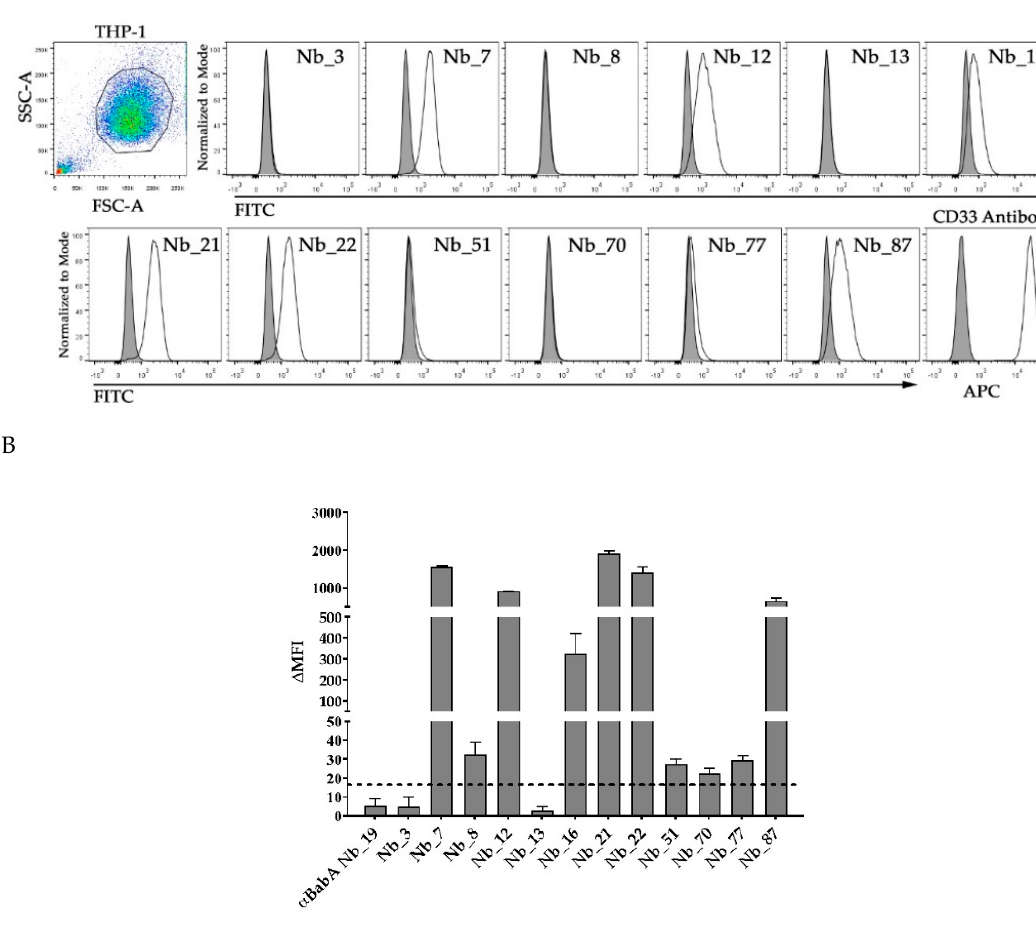
Figure 2. Purity of the anti-CD33 Nb preparations. ( A ) SEC profile of the Nb_12, showing a single peak of protein. (All other Nbs gave comparable chromatograms). ( B , C ) SDS-PAGE under reducing conditions, where proteins are revealed after staining with Coomassie blue ( B ) or by western blot, using a mouse anti-HA tag monoclonal antibody and a goat anti-mouse IgG horse radish peroxidase (HRP)-conjugated antibody ( C ). For both staining conditions and for each Nb preparation, only one single band was revealed.